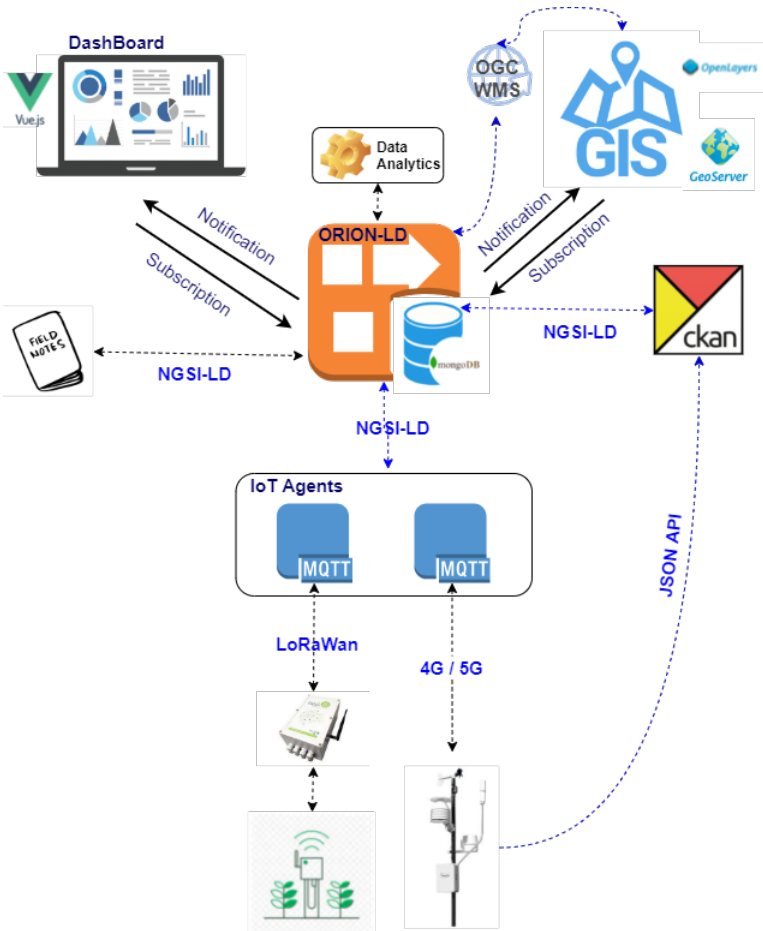
Figure 3. The scheme followed for the implementation of the proposed